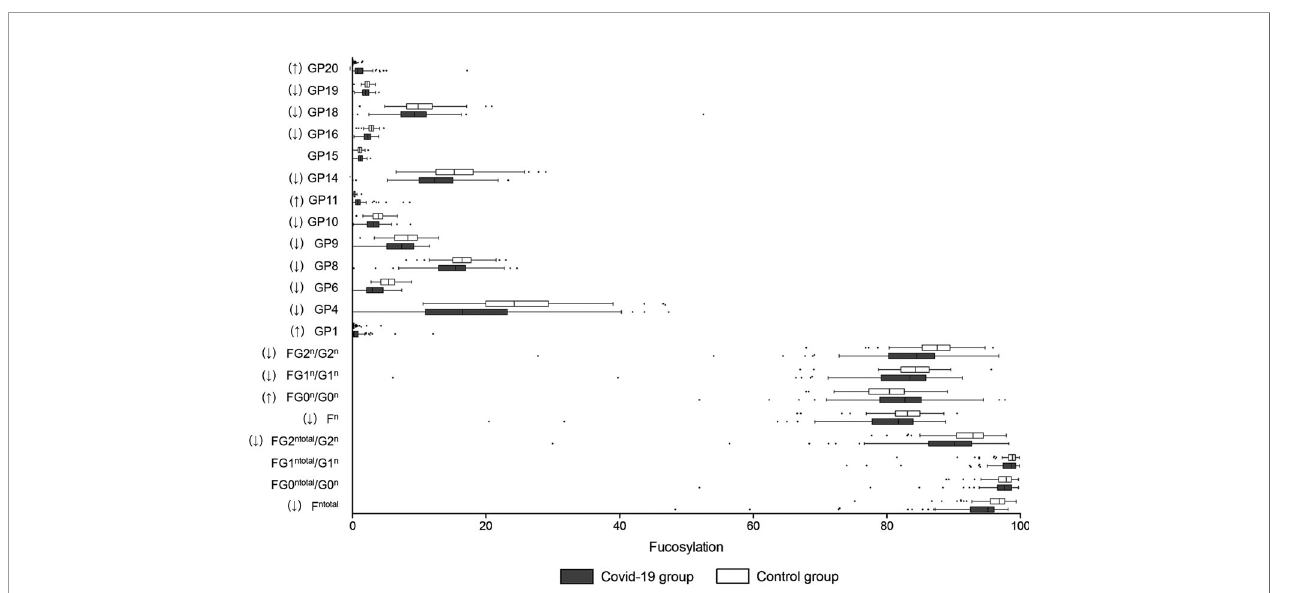
FIGURE 1 | Fucosylation on IgG in COVID-19 patients and the healthy controls. B, bisecting N-acetylglucosamine (GlcNAc); F, fucose; G, galactose; GP, glycan peak; S, Sialic acid; ↑ , the glycan in COVID-19 group is signi fi cantly higher than that in the controls; ↓ , the glycan in COVID-19 group is signi fi cantly lower than that in the